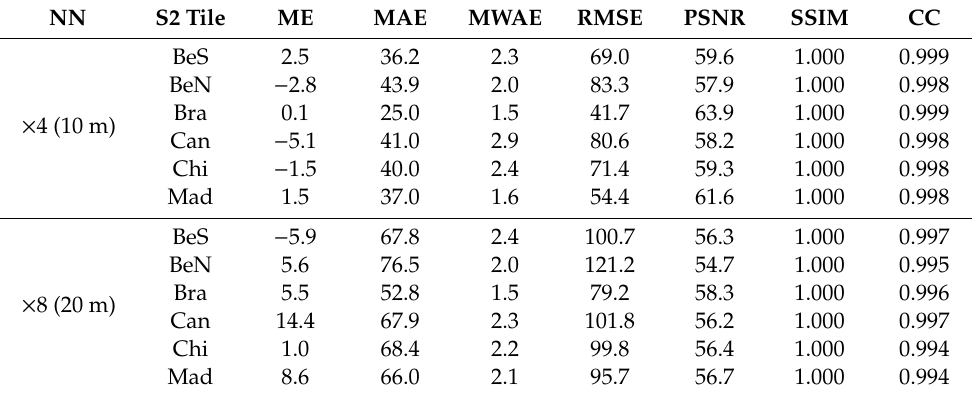
Table 3. Measured quality of the two super-resolution neural networks (NNs): from 10 to 2.5 m ( × 4) and from 20 to 2.5 m ( × 8). Overall quality (i.e., whole tile and all bands together) for the six selected S2 tiles (Figure 2) (Table 1). ME, mean error; MAE, mean absolute error; MWAE (%), mean weighted absolute error; RMSE, root mean square error; PSNR, peak signal noise ratio; SSIM, structure similarity. CC, cross